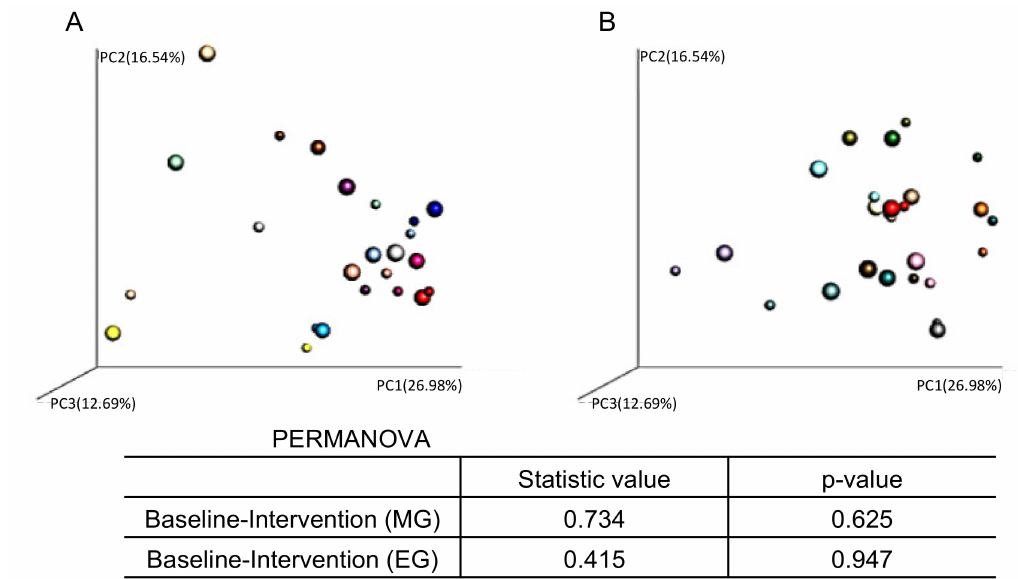
Figure 7. Individual comparison of fecal microbiome β -diversity (weighted UniFrac) in the ( A ) morning group and ( B ) evening group. The small plot indicates the baseline results. The large plot indicates the results after the